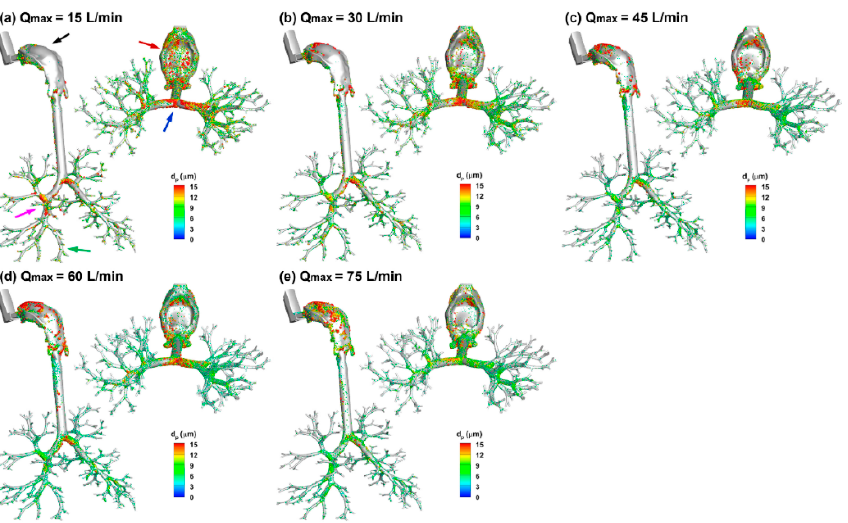
Figure 10. Surface deposition of MDI sprays for varying breathing depths (Q max ): ( a ) 15 L/min, ( b ) 30 L/min, ( c ) 45 L/min, ( d ) 60 L/min, and ( e ) 75 L/min.